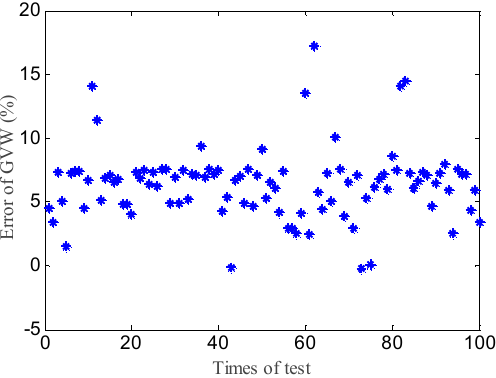
Figure 12. The identified errors of the GVW with 20% noise when d =32cm .